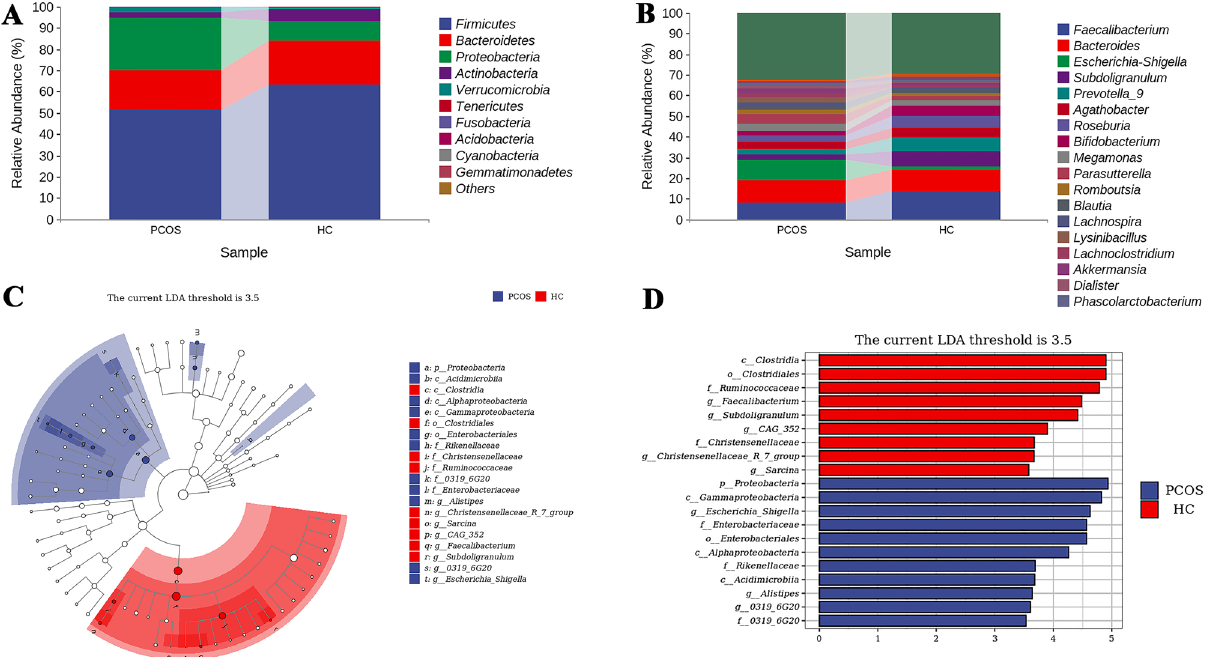
Figure 3. Gut microbiota composition differences between PCOS and HC. The relative abundance of the gut microbiome at phylum level (Top 10) ( A ); and at genus level ( B ); Lefse analysis taxonomy branch diagram ( C ); Lefse analysis LDA histogram provided key features of each group (LDA > 3.5) ( D